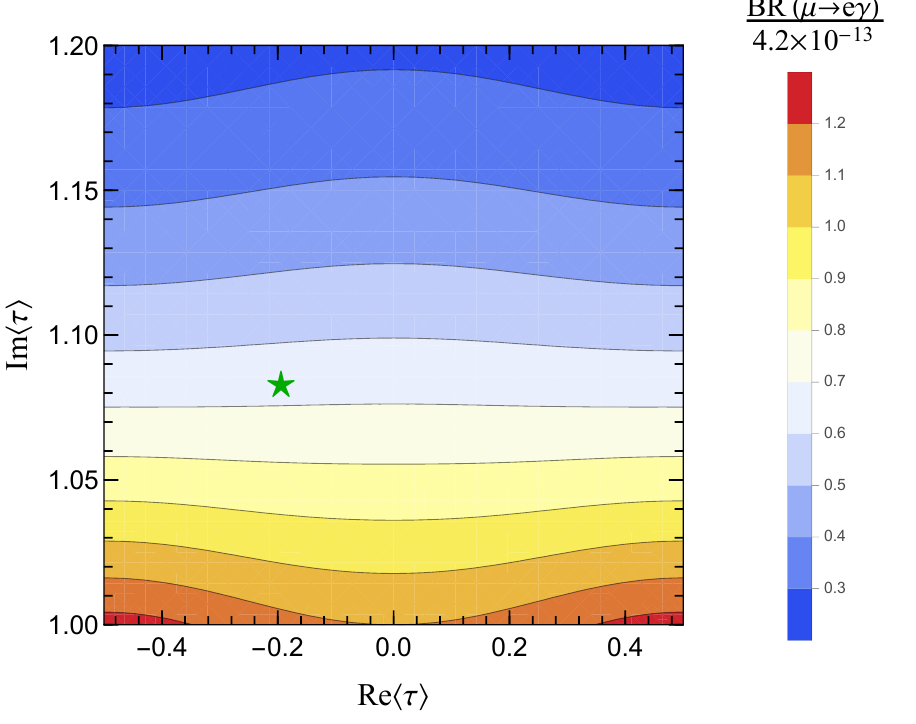
= 5 TeV , F τ = m 4 . 0 / 1 / 2